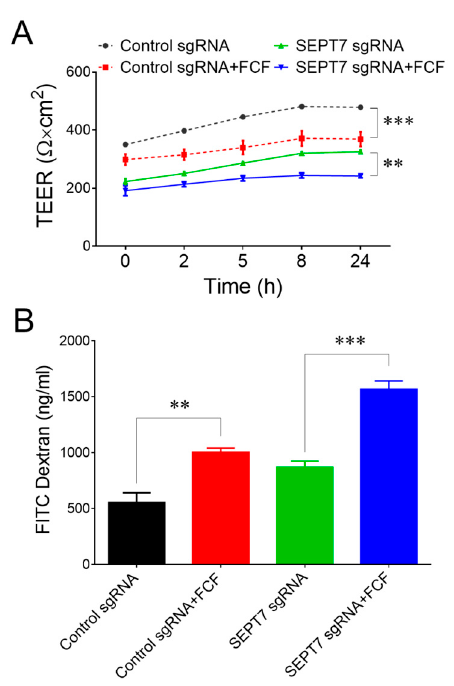
Figure 6. Forchlorfenuron disrupts barrier integrity in colonic epithelial cell monolayers. Control and SEPT7-depleted HT-29 cell monolayers were treated with either FCF (50 µ M) or vehicle. Epithelial barrier integrity was examined by measuring transepithelial electrical resistance (TEER) at the indicated times ( A ) or by measuring transepithelial FITC-dextran flux after 24 h of FCF treatment ( B ). Data are presented as mean ± SE ( n = 3); ** p < 0.01, *** p < 0.001.